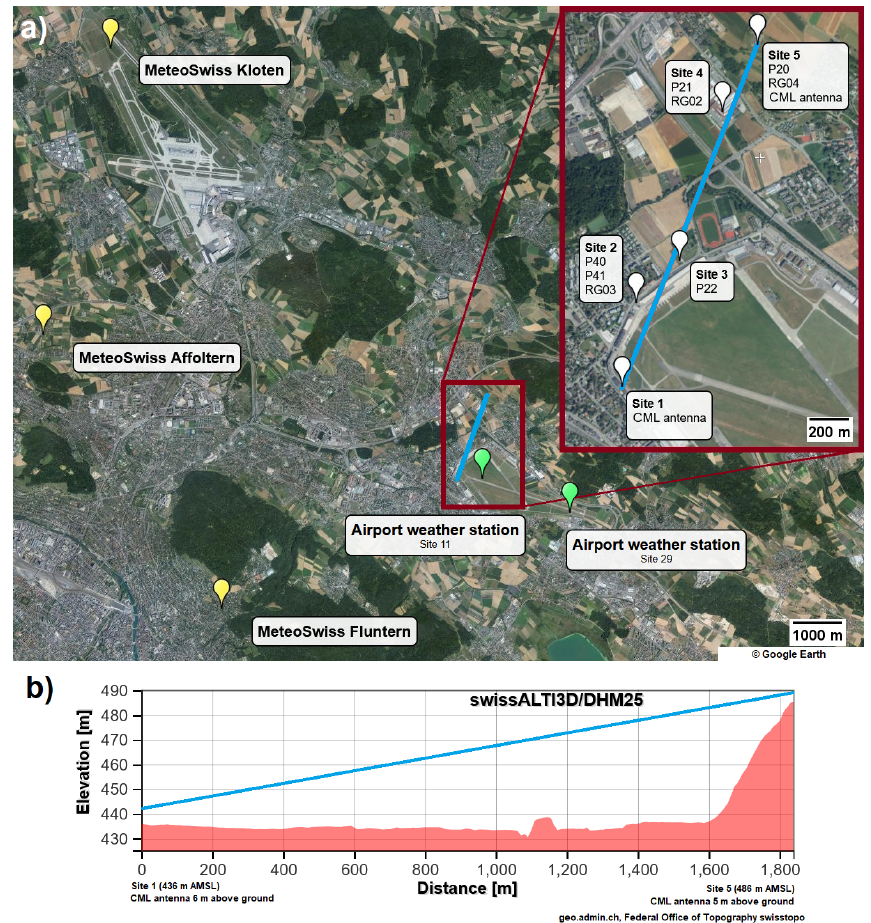
Figure 1. (a) Layout of the CoMMon field campaign. The radio units are deployed at the end sites (site 1 and site 5). The path of the CML is in blue. Disdrometer (P, Parsivel) and rain gauge (RG, rain gauge) positions are indicated by white pins. Site 2 contained two co-located disdrometers for data quality control. Except for site 3, all rain gauges have a co-located disdrometer. The MeteoSwiss weather stations (yellow pins) are within 6 to 11km away. Two additional weather stations (green) are located at the Dübendorf airport (site 11 and site 29). ©